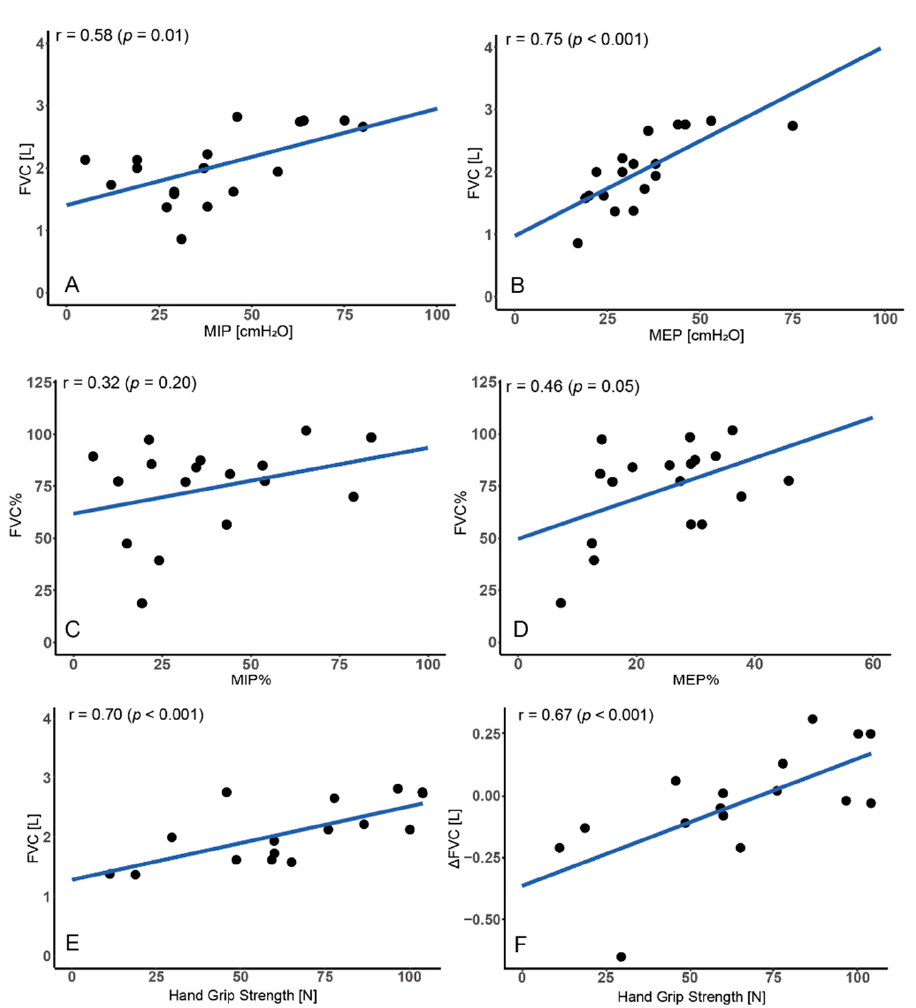
Figure 3. Relationship between forced vital capacity (FVC) and ( A , B ) maximal inspiratory pressure (MIP); ( C , D ) maximal expiratory pressure (MEP); ( E , F ) handgrip strength.